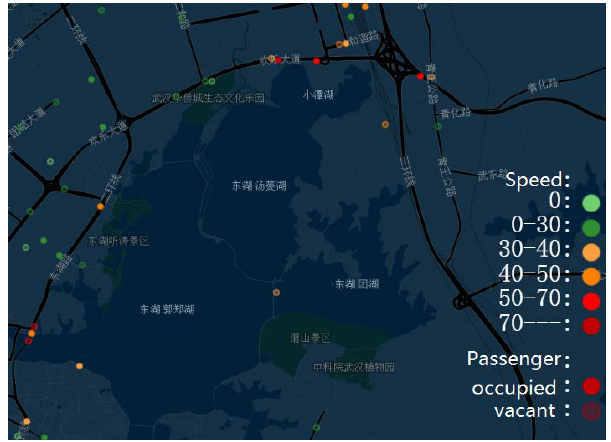
Figure 6. Visualization of speed and passenger information.